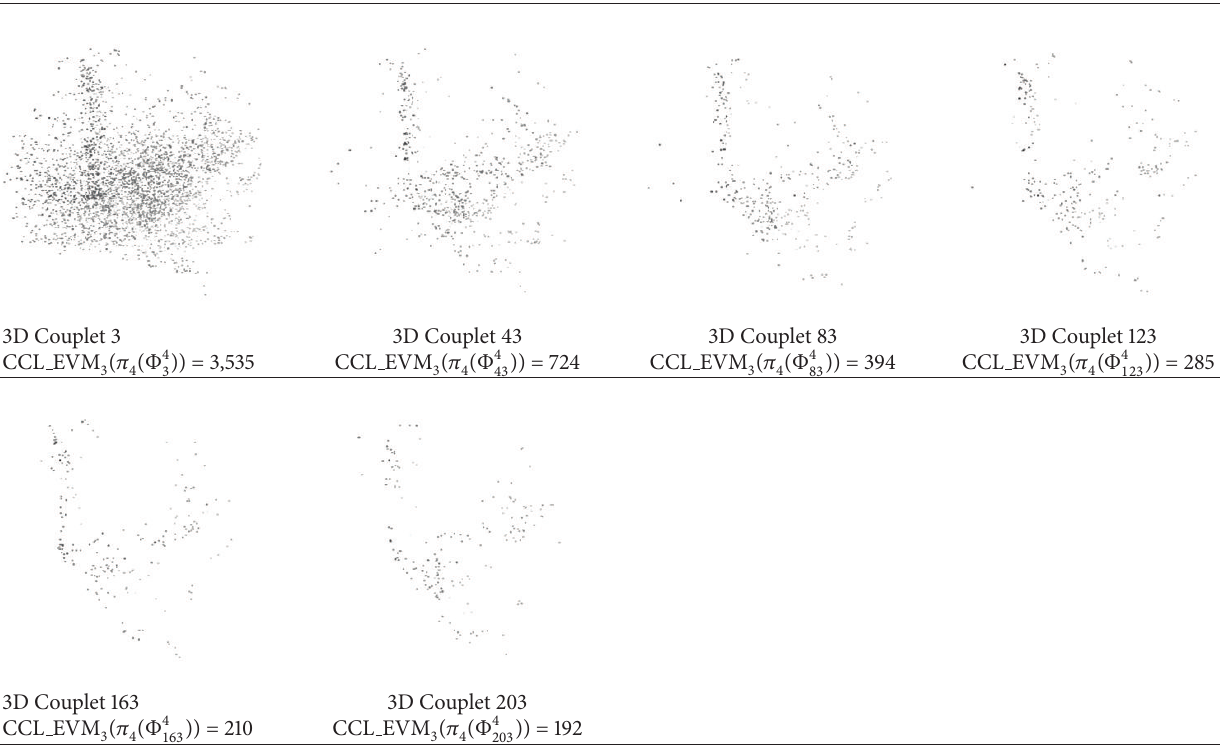
Table 3: Some 3D Couplets, perpendicular to color axis, extracted from the 4D-EVM associated to dataset Aneurism